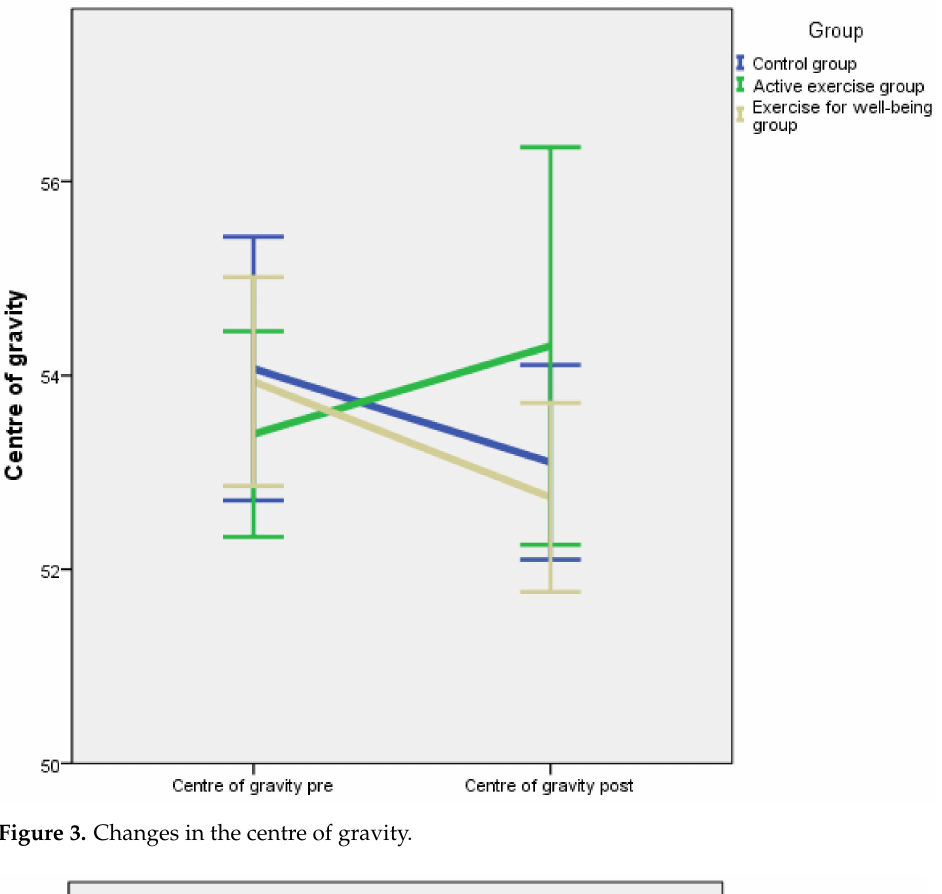
Figure 3. Changes in the centre of gravity.